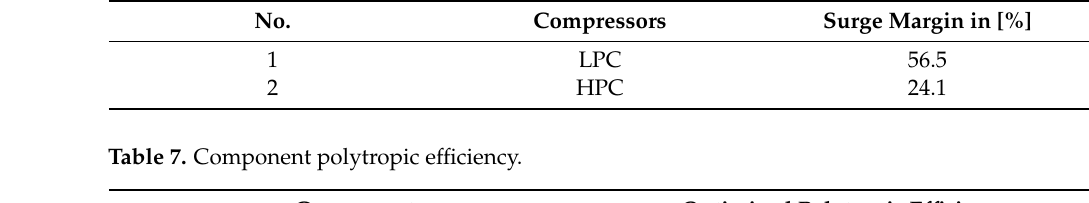
Table 6. Compressor surge margin.